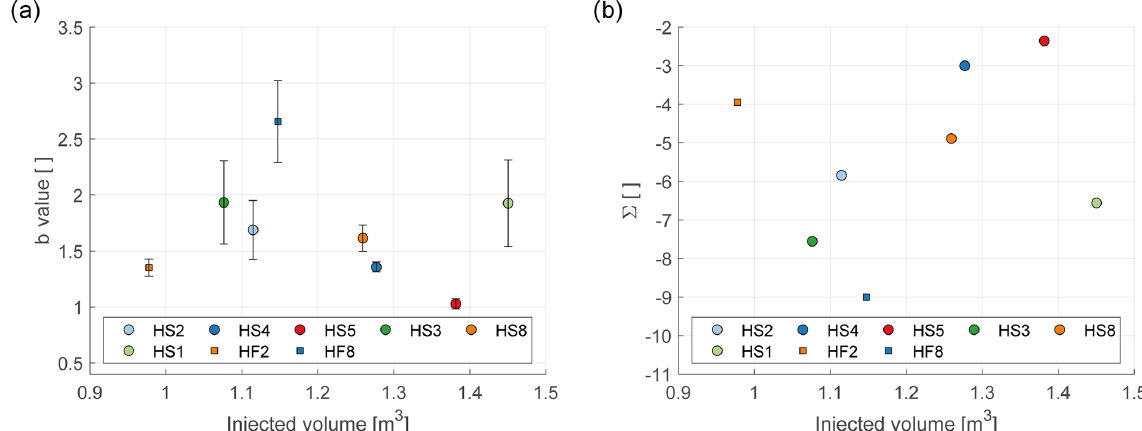
Figure 11. (a) b values along with uncertainties plotted against seismically activated area and (b) seismogenic indices plotted against seismically activated area from experiments for which the b values, seismogenic indices, and areas could be